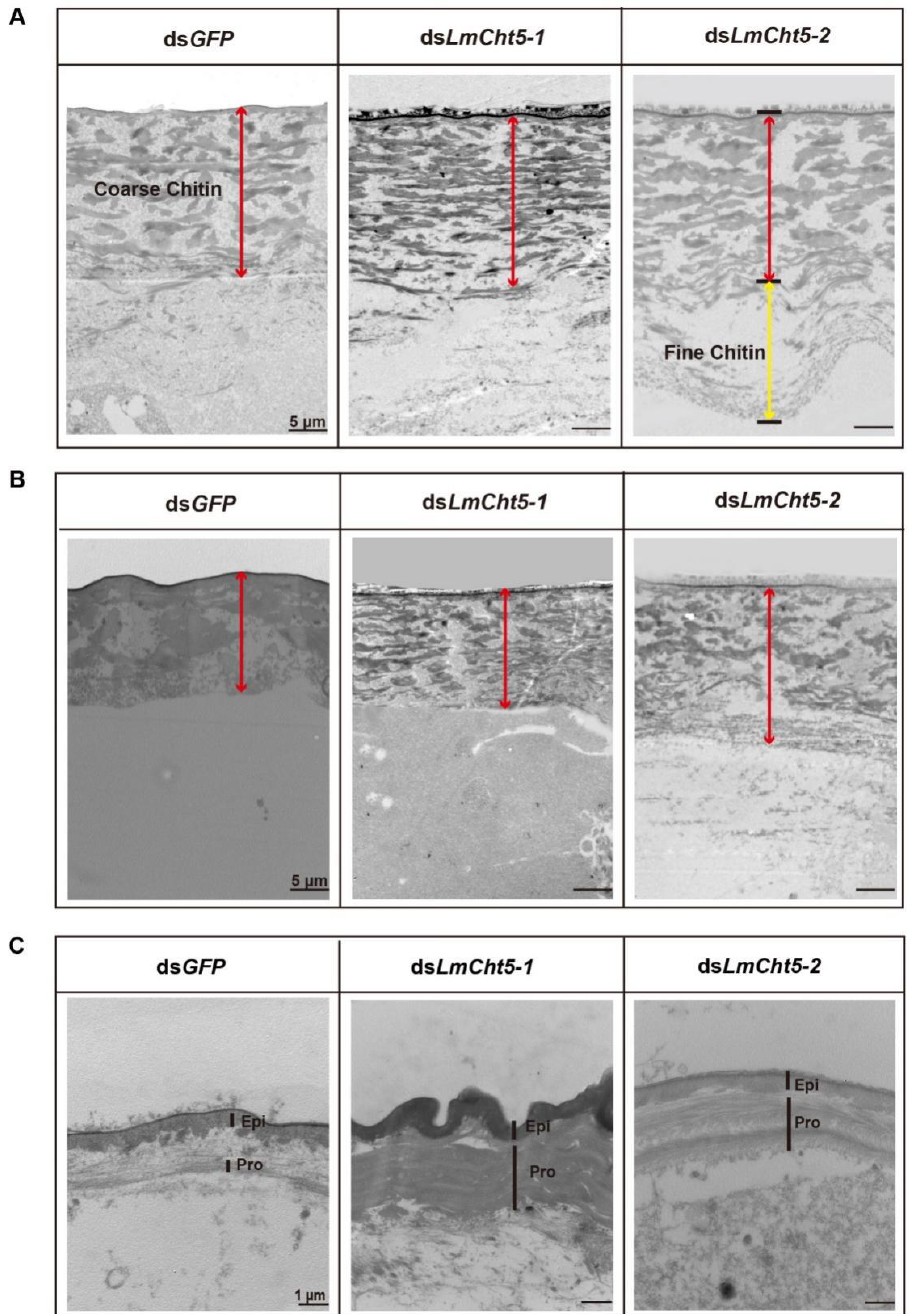
Figure 5. TEM analysis of the function of ds LmCht5-1 and ds LmCht5-2 on the degradation of the serosal cuticle and pro-nymph cuticle. ( A ). While ds LmCht5-1 suppresses the loss of coarser structures on the upper layer of the serosal cuticle, ds LmCht5-2 inhibits the degradation of fine structures on the lower layer by dsRNA microinjection at E5. ( B ). While ds LmCht5-1 still suppresses the loss of coarser structures on the upper layer of the serosal cuticle, ds LmCht5-2 inhibits the further degradation of looser coarser structures at E13 by dsRNA microinjection at E7. ( C ) . While ds LmCht5-1 inhibits the loss of the layer structure of the procuticle, ds LmCht5-2 suppresses the further degradation of the chitin structure layer at E13 by dsRNA microinjection at E7. Scale bar in ( A , B ) is 5 µ m. The red line shows the coarse layer in the upper part, while the yellow line shows the fine layer in the lower part. Scale bar in ( C ) is 1 µ m. Epi: Epicuticle; Pro: